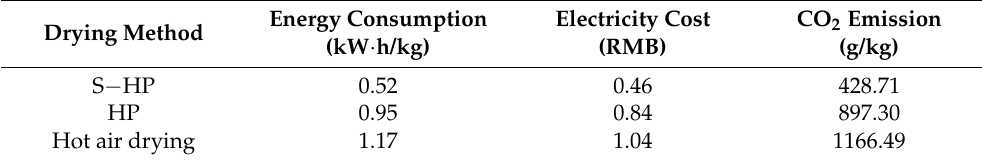
Table 9. Energy consumption of different drying